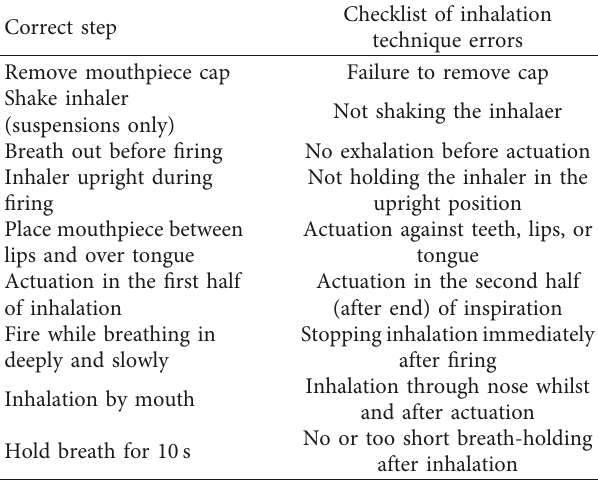
Table 1: MDI checklist of proper inhalation technique and errors.